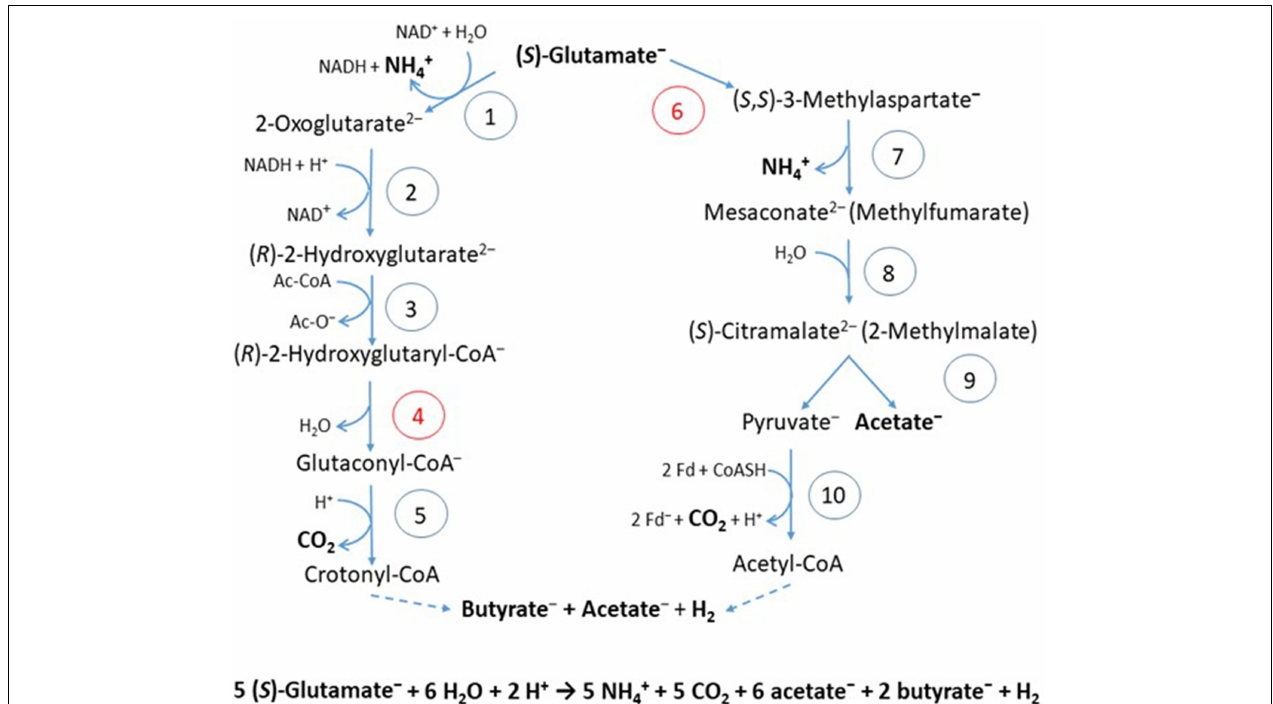
FIGURE 4 | Fermentation of glutamate via 2-hydroxyglutarate or via 3-methylaspartate. The numbers in the circles represent the corresponding enzymes; red numbers denote radical enzymes: 1, ( S )-glutamate dehydrogenase; 2, ( R )-2-hydroxyglutarate dehydrogenase; 3, glutaconate CoA-transferase; 4, ( R )-2-hydroxyglutaryl-CoA dehydratase; 5, glutaconyl-CoA decarboxylase, Na + -pumping; 6, glutamate mutase, coenzyme B 12 -dependent; 7, methylaspartase; 8, mesaconase; 9, ( S )-citramalate lyase; 10, pyruvate:ferredoxin oxidoreductase (PFOR). Ac-CoA, acetyl or glutaconyl-CoA; Fd, ferredoxin; Fd − , reduced ferredoxin. The formation of butyrate and acetate are shown in Figure 5 . Hydrogen, H 2 is formed from 2 H + and 2 Fd − , catalyzed by a [FeFe]-hydrogenase.